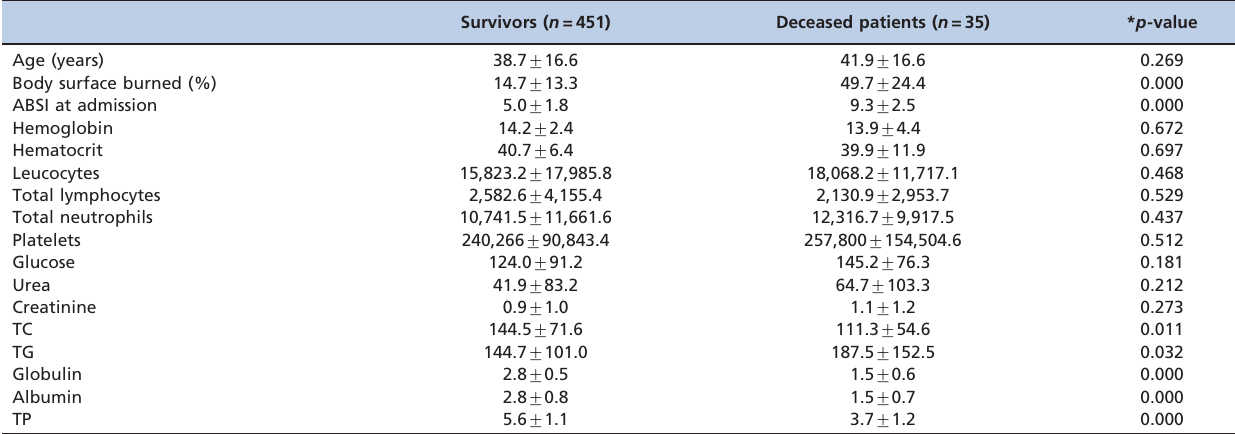
Table 4 - Analysis of quantitative